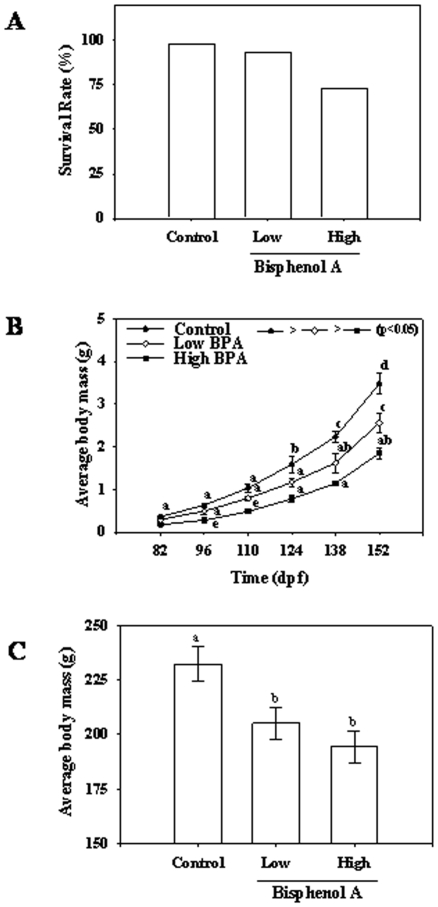
Impact of bisphenol A (BPA) on survival and growth.(A) Percent survival of trout embryos was calculated at the end of the experimental period (400-dpf). (B) Temporal changes in average body mass (g), measured every two weeks after the time of first feed (65 dpf), in the control and BPA exposed groups during development, and (C) in juveniles at 400 dpf. Oocytes were exposed to either control (vehicle alone) or BPA at 30 µg.ml−1 (low) or 100 µg.ml−1 (high) for 3 h and fertilized with untreated sperm. Fertilized eggs were incubated at 8.5°C and were sampled at various time points during development; values represent mean + SEM (n = 6); bars with different letters are statistically significant (two-way ANOVA for temporal changes and one-way ANOVA for single time point; p<0.05).